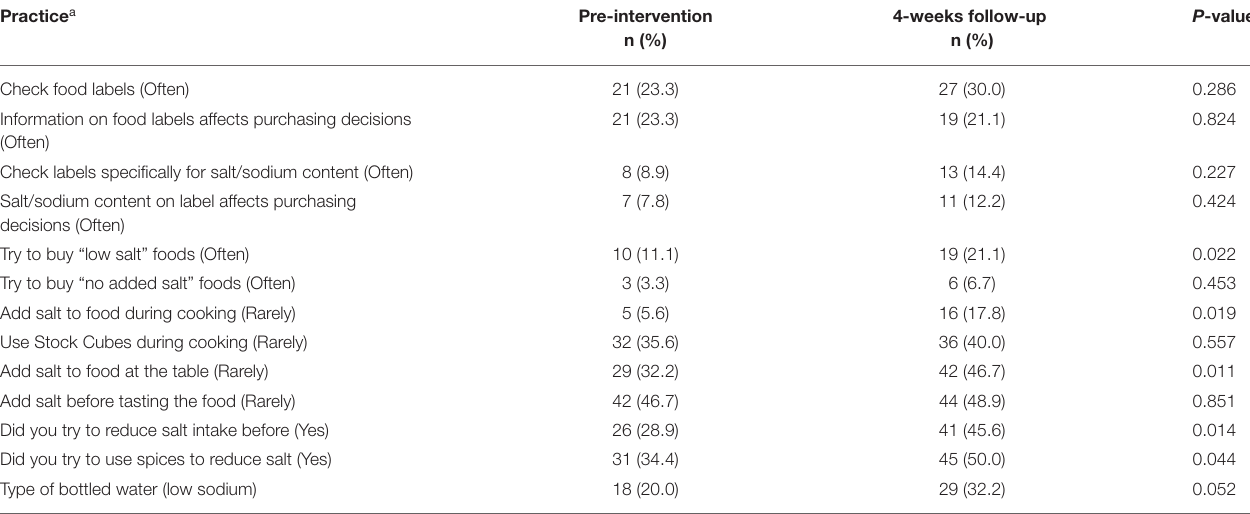
TABLE 4 | Pre-intervention and 4-week follow-up for practice related responses of study participants ( n = 90). Practice a Pre-intervention